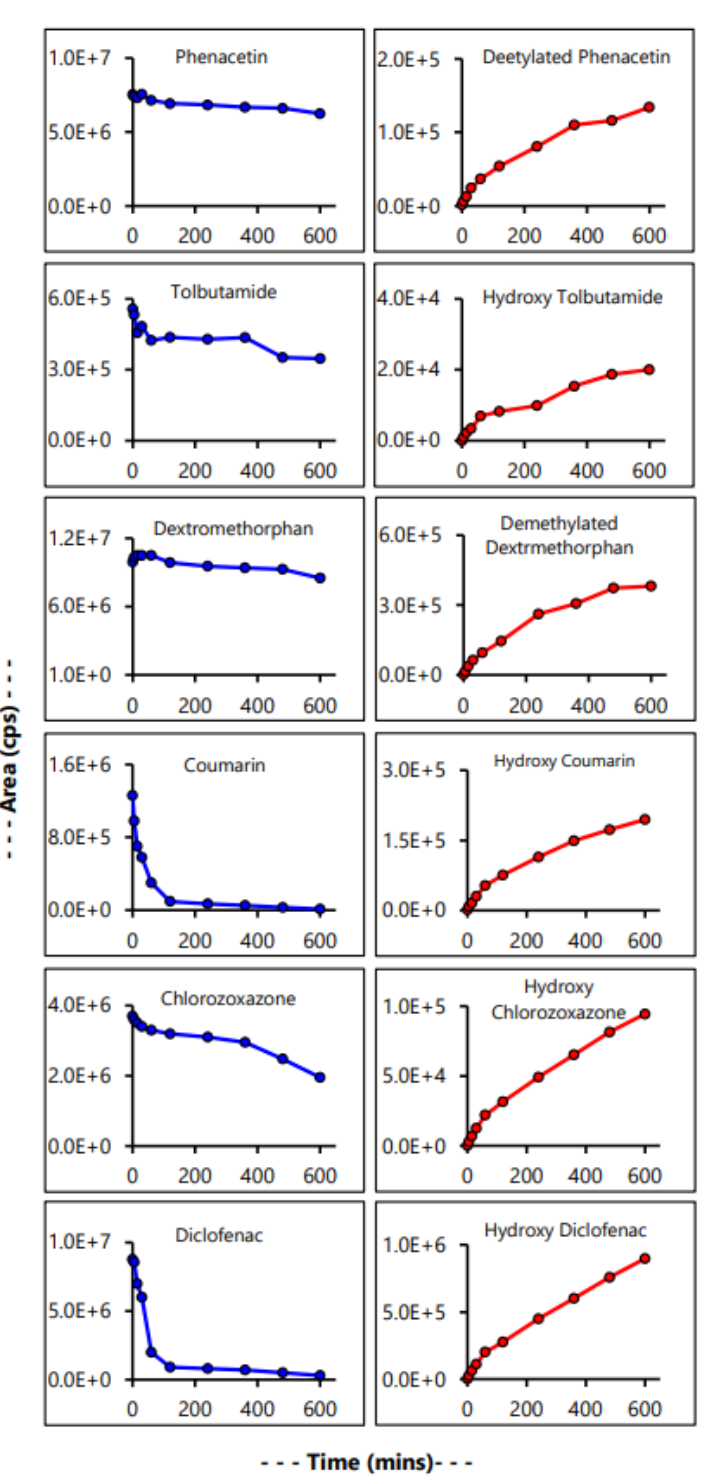
Figure 6. Time kinetics study of control CYP substrates. Blue line indicates disappearance of parent drug, with respect to time; red line indicates formation of major drug metabolite, with respect to time.